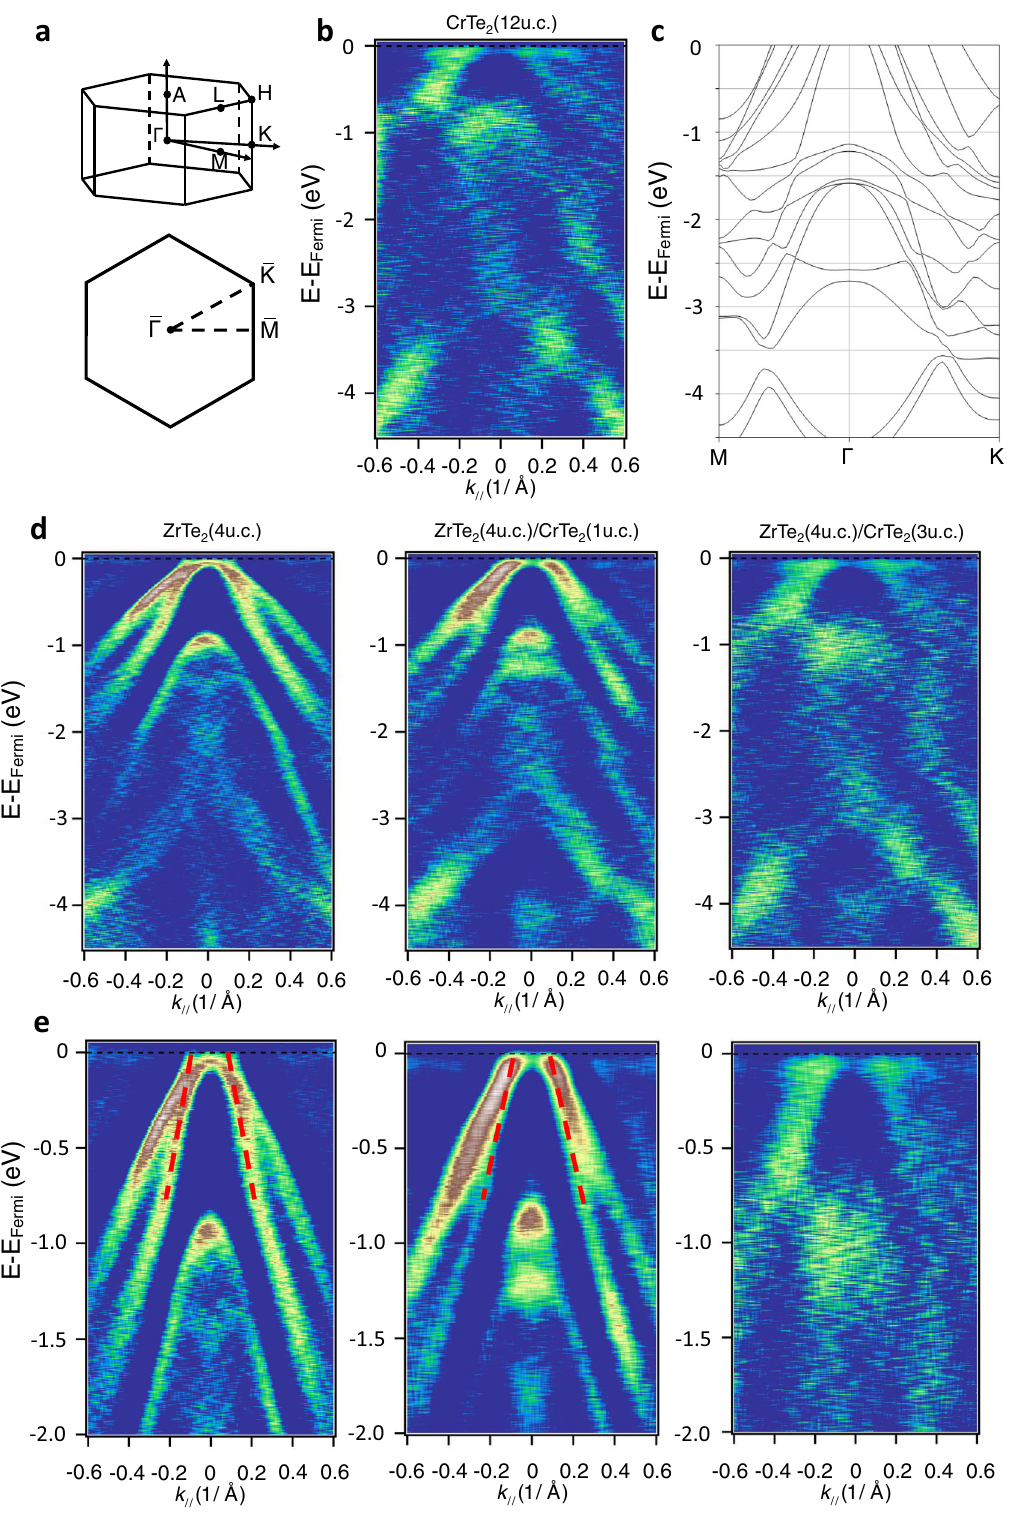
Fig. 2 ARPES measurements and DFT calculation of the band structure of 1T-CrTe 2 thin fi lms. a Schematic of the bulk and projected Brillouin zones of CrTe 2 . b ARPES spectrum of a single layer of 12 u.c. CrTe 2 in the (cid:1) Γ (cid:2) (cid:1) M direction. c DFT calculation of the band structure of bulk CrTe 2 . The M and K points are 0.92 and 1.06 Å − 1 respectively. d , e ARPES spectrum of the 4 u.c. ZrTe 2 (left), ZrTe 2 (4 u.c.)/CrTe 2 (1 u.c.) (middle), and ZrTe 2 (4 u.c.)/CrTe 2 (3 u.c.) (right) with a larger ( d ) and smaller ( e ) binding energy scale. All the ARPES data were taken at 300 K with 21.2 eV excitation from a He lamp. To more clearly highlight the measured band dispersion, we present all plots as second-derivatives with respect to the energy. The red dashed lines are guides to the eyes for the Dirac dispersion in ZrTe 2